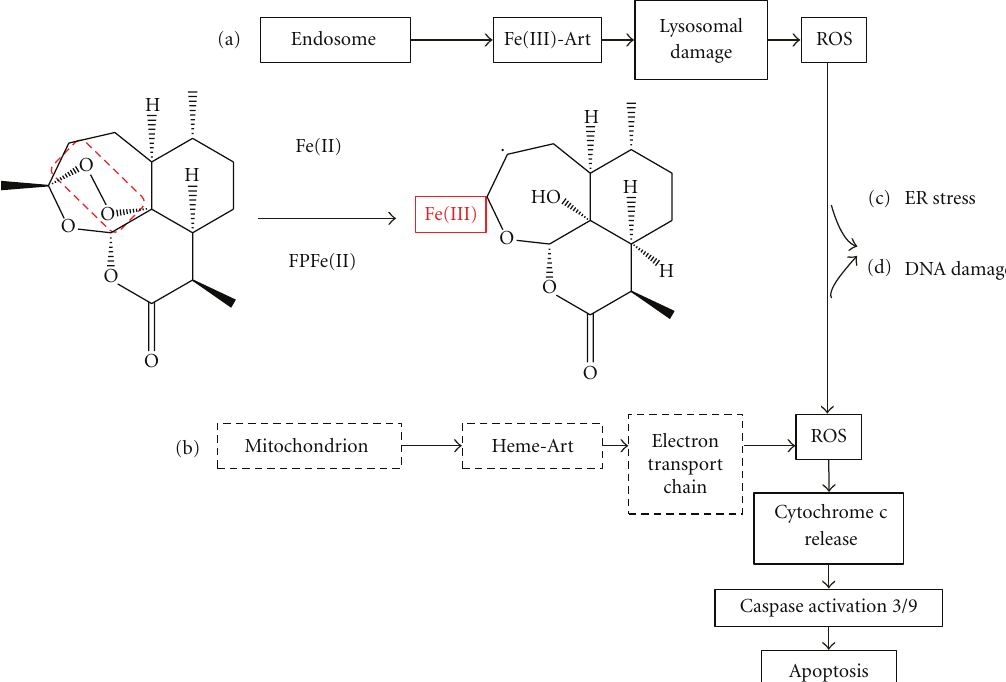
Figure 2: Postulated anticancer mechanisms of action of artemisinins. (a) It has been postulated that bioactivation of artemisinin occurs in the endosome after pH-induced release of iron from internalized transferrin. Iron activated-artemisinin generates carbon-centered radicals which may mediate lysosomal disruption and generation of ROS resulting in mitochondrial damage, activation of caspases, and cell death. (b) Alternatively, it has been suggested that only specific activation of artemisinin by heme or heme-bound protein generates cytotoxic- carbon-centered radicals. In the mitochondrion, these adducts interfere with the electron transfer chain (ETC) by interacting with heme or heme-bound proteins leading to generation of ROS and apoptosis. (c) ROS harboring may induce ER stress and (d)